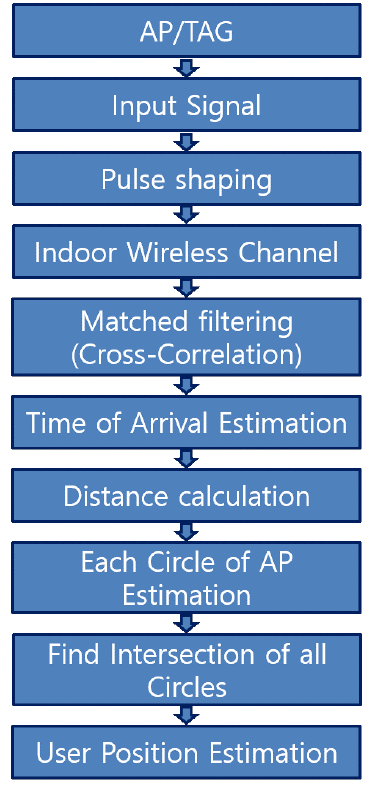
Figure 2. UWB based localization